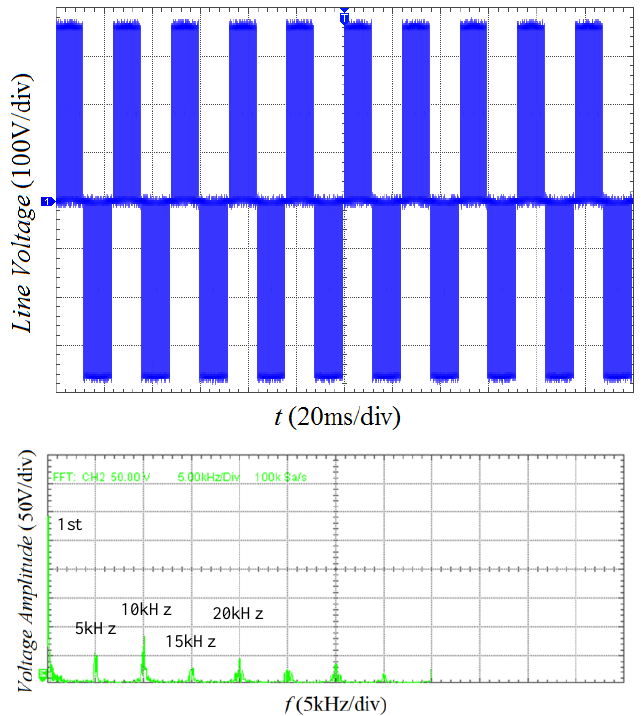
Figure 24. Experimental result of DZIPWM at m = 0.9703: ( top ) line voltage u ab ; ( bottom ) the FFT analysis of u ab .